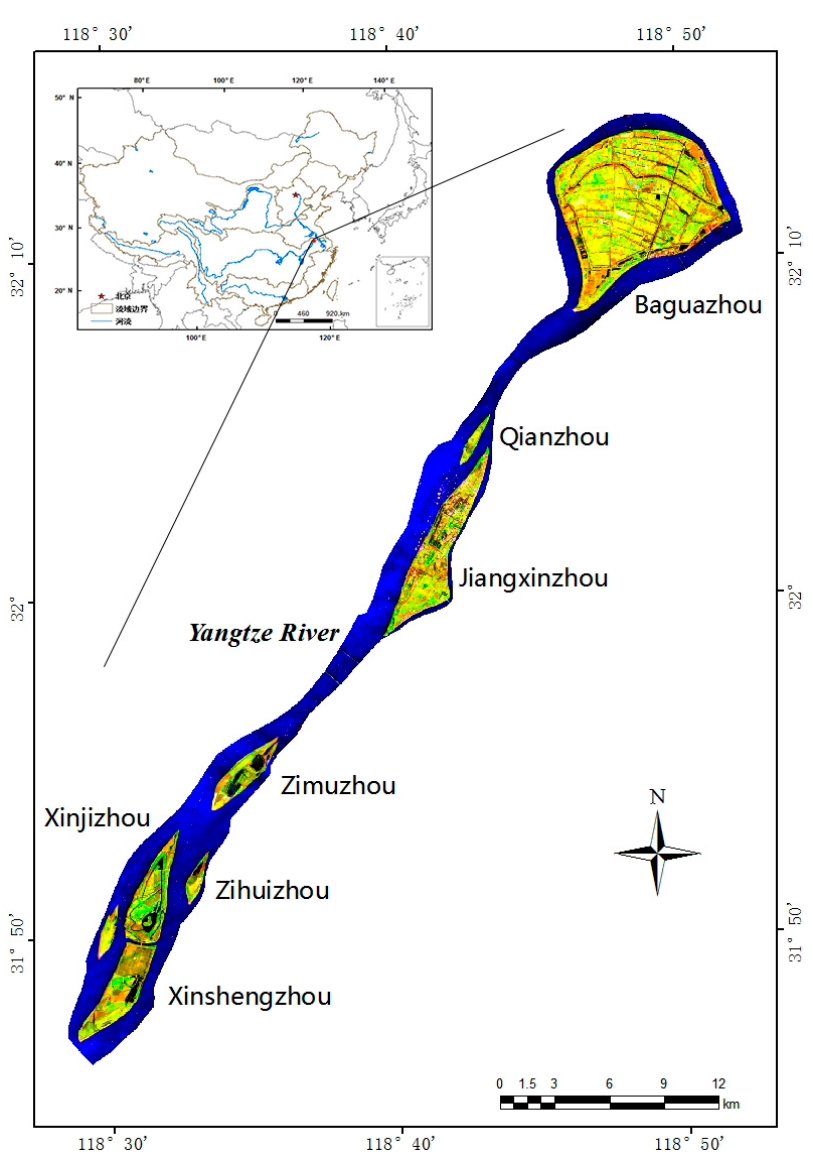
Figure 1. Map of the Nanjing Section of the Yangtze River, showing the river islands Xinshengzhou, Xinjizhou, Zihuizhou, Zimuzhou, Jiangxinzhou, Qianzhou and Baguazhou by Landsat7 ETM+ acquired on 12 October 2015.